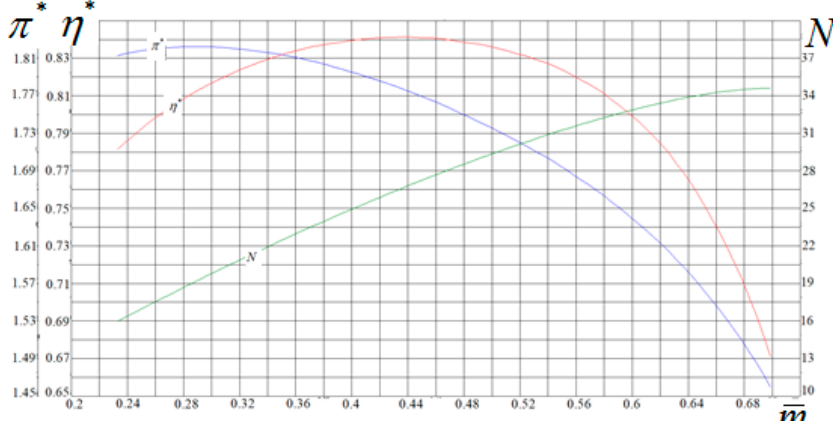
Figure 3. CCPC-G9E program. Characteristics of the TKR 140E compressor with a flow path according to the primary design.